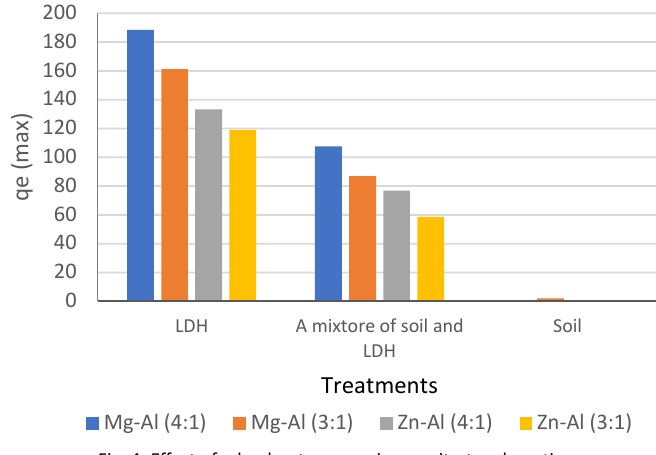
Fig. 4: Effect of adsorbents on maximum nitrate adsorption